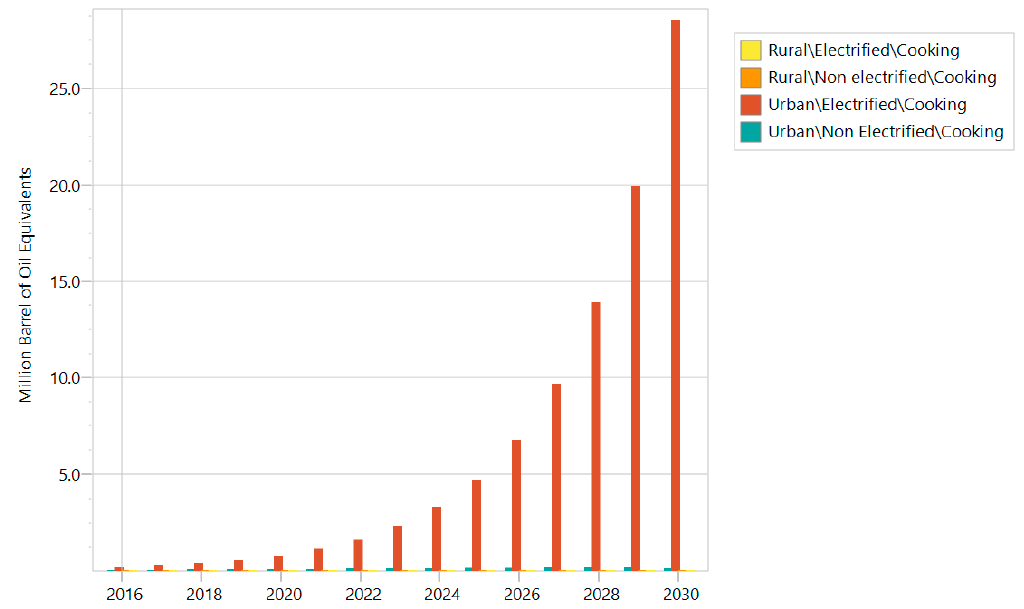
Figure 15. LPG consumption for the stoves plus LPG scenario.